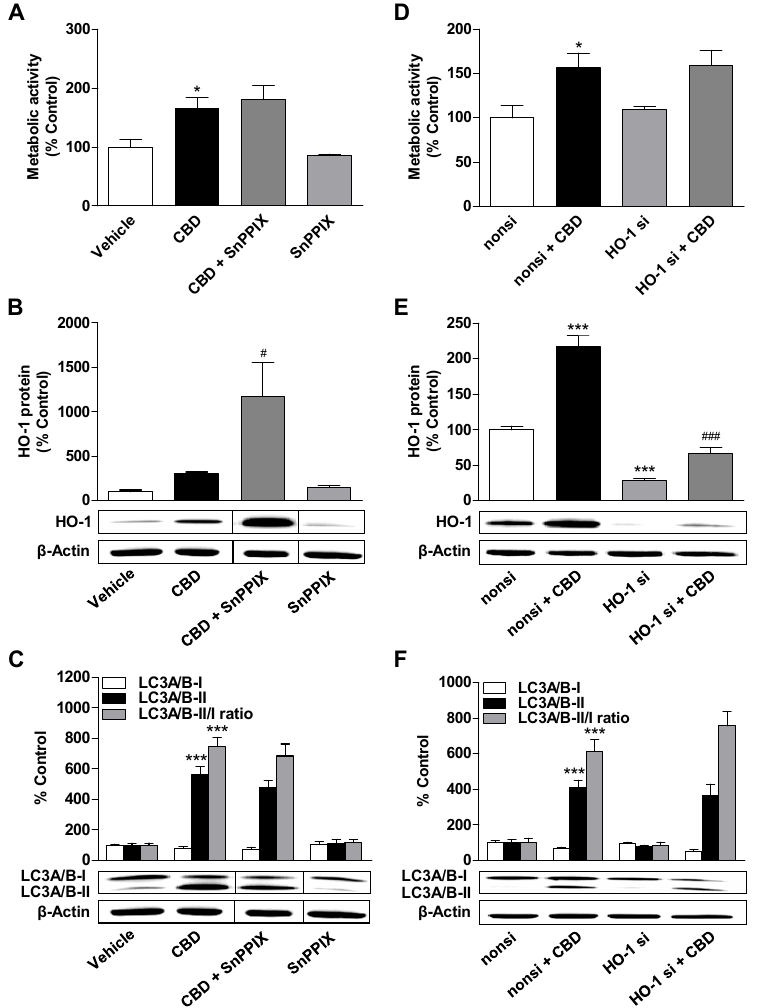
Figure 4. Impact of the HO-1 inhibitor SnPPIX and HO-1 siRNA on the effects of CBD on metabolic activity, autophagy, and HO-1 expression. ADMSCs were pretreated with the HO-1 inhibitor SnPPIX (25 µM) for 30 min prior to CBD (3 µM) stimulation for 24 h ( A – C ). In other experiments ( D – F ), the cells were transfected with HO-1 specific siRNA (HO-1 si) or nonsilencing siRNA (nonsi; negative control siRNA) at a final concentration of 12 nM and then incubated with CBD (3 µM) or vehicle for another 24 h. After the respective incubation periods, the cells were analyzed for their metabolic activity ( A , D ) and for the expression of HO-1 ( B , E ) and LC3A/B-I/II ( C , F ) protein. The protein expression values were normalized to β -actin. The vertical black lines inside the boxes of some blots ( B , C ) indicate that the lanes in between have been removed, so here too, signals from protein samples loaded onto the same gel were compared. The same actin blot was used as control in ( B , C ), since the proteins analyzed in these Western blots were resolved on the same gel. The percentage control represents a comparison with the group treated with the vehicle (set to 100%). The data represent mean values ± SEM of n = 6 different donors ( A – F ). * p < 0.05, *** p < 0.001 vs. vehicle or nonsilencing siRNA control; # p < 0.05, ### p < 0.001 vs. CBD ( B ) or nonsi + CBD ( E ); one-way ANOVA with Bonferroni’s post hoc